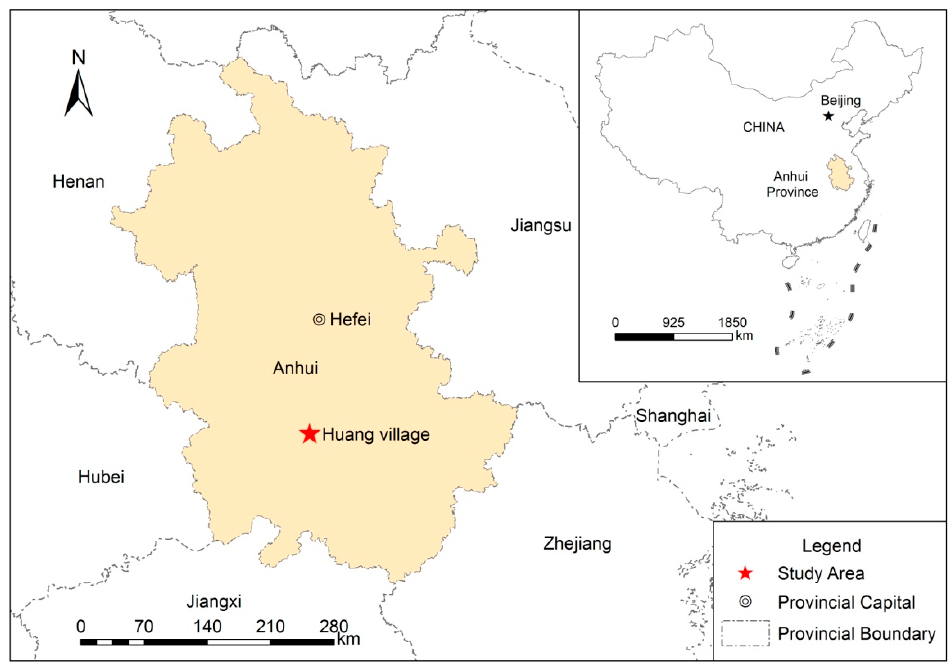
Figure 1. Location of the study